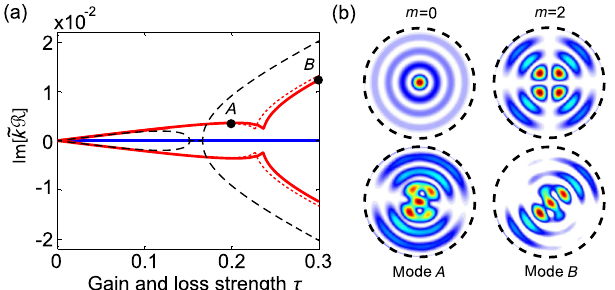
FIG. 6. Restoration of the PT -symmetric phase due to multi- mode coupling. (a) Evolution of the imaginary part of two m ¼ 2 and one m ¼ 0 eigenfrequencies as a function of the gain and loss strength τ (solid lines) in the PT -symmetric disk studied in Fig. 1. k 0 R ¼ 2 . 62 and k 2 R ¼ 2 . 55 at τ ¼ 0 . Dotted lines show the three-mode approximation (7). Dashed lines show the case if the coupling between the m ¼ 0 mode and the odd-parity m ¼ 2 mode increased by 30%, which exhibits a restored PT -symmetric phase in τ ∈ ½ 0 . 152 ; 0 . 166 (cid:2) . (b) Top: Intensity profiles of the m ¼ 0 mode and the odd-parity m ¼ 2 mode at τ ¼ 0 . Bottom: The PT symmetry-broken modes A and B at τ ¼ 0 . 2 ; 0 . 3 [marked by black dots in (a)]. Only the central regions of r < R= 2 are